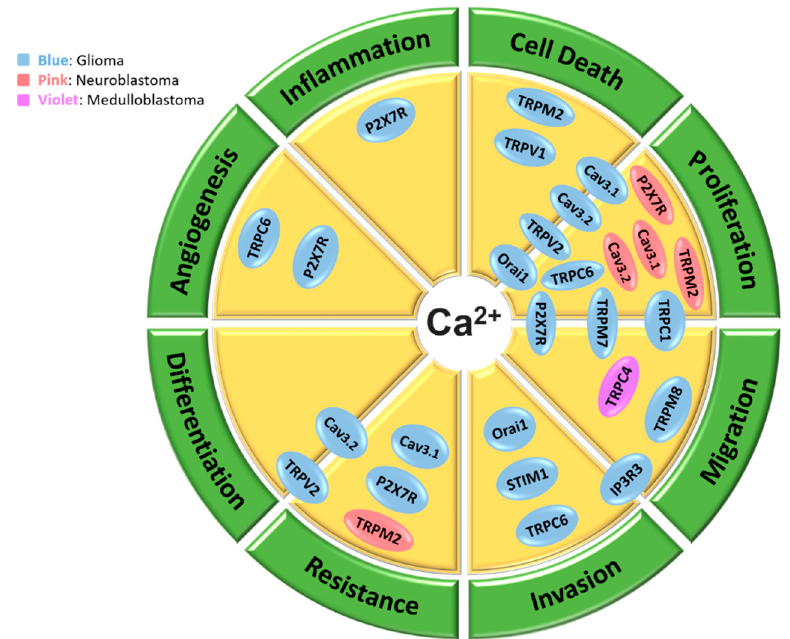
Figure 2 . Schematic representation of biological processes that are promoted by Ca 2+ signaling proteins in brain cancer cells. Several Ca 2+ channels are shown to contribute to various pro-tumor processes in glioma cells (blue color), neuroblastoma cells (pink color) and medulloblastoma cells (violet color). These processes include proliferation, migration, invasion, therapy resistance/therapy sensitivity, differentiation, angiogenesis, inflammation and cell death. Proteins that are positioned on the borders of two processes, contribute to both processes.